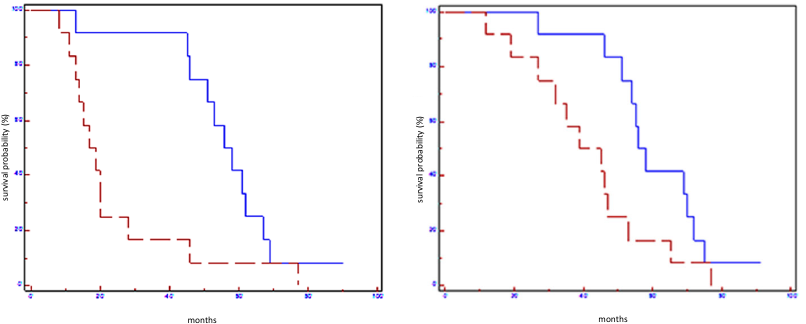
Figure 2. Prognostic impact of miR100 ‐ 5p on EFS (on the left) and on OS (on the right) in all population: blue line refers to patients with overexpression of miR100 ‐ 5p; red line refers to patients without overexpression of miR100 ‐ 5p.